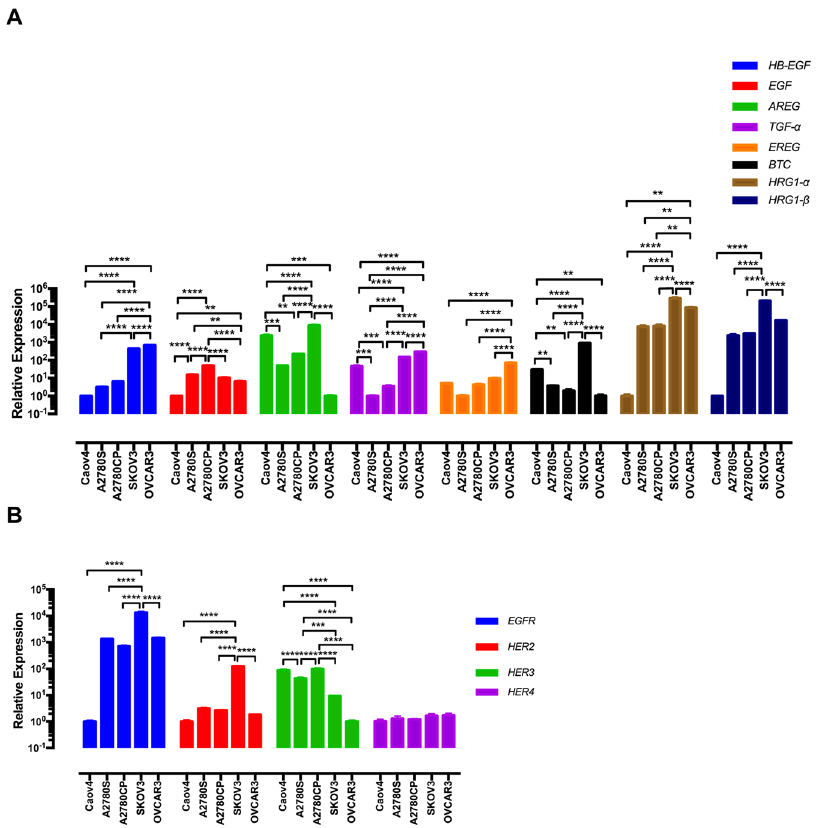
Figure 1. Expression of the ErbB family in the EOC cells. ( A , B ) The mRNA levels of the ErbB family in the EOC cell lines were determined by qRT-PCR. The data were evaluated in triplicate and collected from three independent experiments. Gene expression levels were normalised to B2M in each cell line. Data were analysed by one-way ANOVA followed by Tukey’s post hoc test and are shown as mean ± SD. Statistically significant values of * p < 0.05, ** p < 0.01, *** p < 0.001 and **** p < 0.0001 were